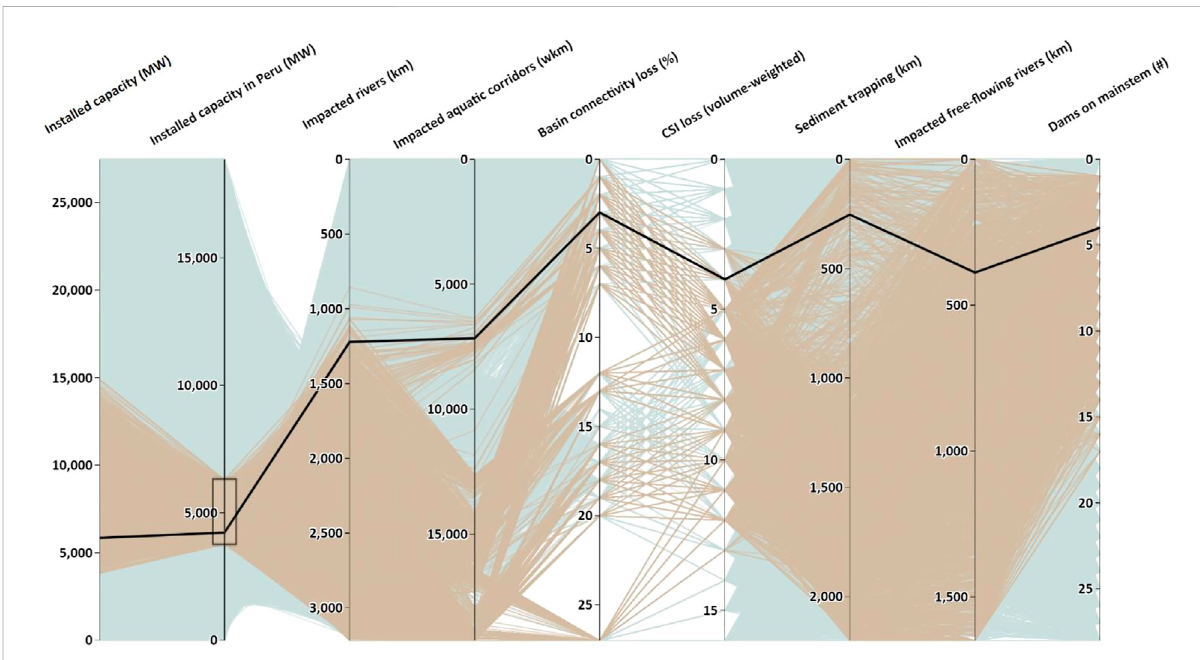
FIGURE 4 Aparallelaxisplotshowinghowalargenumberofdamportfoliosperformacrossarangeofmetrics(fromalargebasininPeruwithunpublished data,usedheretoillustratetheutilityofthistypeof fi gure). Eachportfolioisrepresentedbyagraypaththatcrossestheaxes,withoneaxispermetric (in most of the fi gure, the high number of gray lines gives the appearance of gray shading). Where each path crosses an axis depicts the correspondingportfolio ’ sperformanceagainst thatmetric.Foreachmetric,the “ desired ” performanceisatthetopoftheaxis(e.g.,fornegative impacts, such as “ impacted kilometers, ” zero is at the top of the axis; for positive outcomes, such as capacity, zero is at the bottom). Here, a single portfolio is selected and shown as a black line. This plot is from a decision support tool that allows users to select ranges for a metric, here indicated by asquare along the axis for installed capacity. All portfolios that fall within that range are shown in brown. By selecting ranges across multiple axes, users can quickly fi lter through tens of thousands of portfolios to fi nd the sub-set that ful fi lls the selected